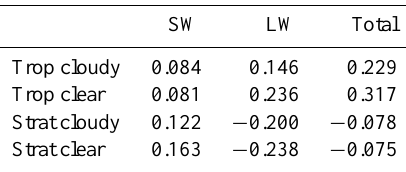
Table 5. Global mean tropospheric (Trop) and stratospheric (Strat) ozone radiative forcings (Wm − 2 , at the tropopause, after allow- ing for stratospheric temperature adjustment following the fixed dy- namical heating approximation) for the 2000s relative to the 1850s, split into short-wave (SW) and long-wave (LW) components, for cloudy and clear